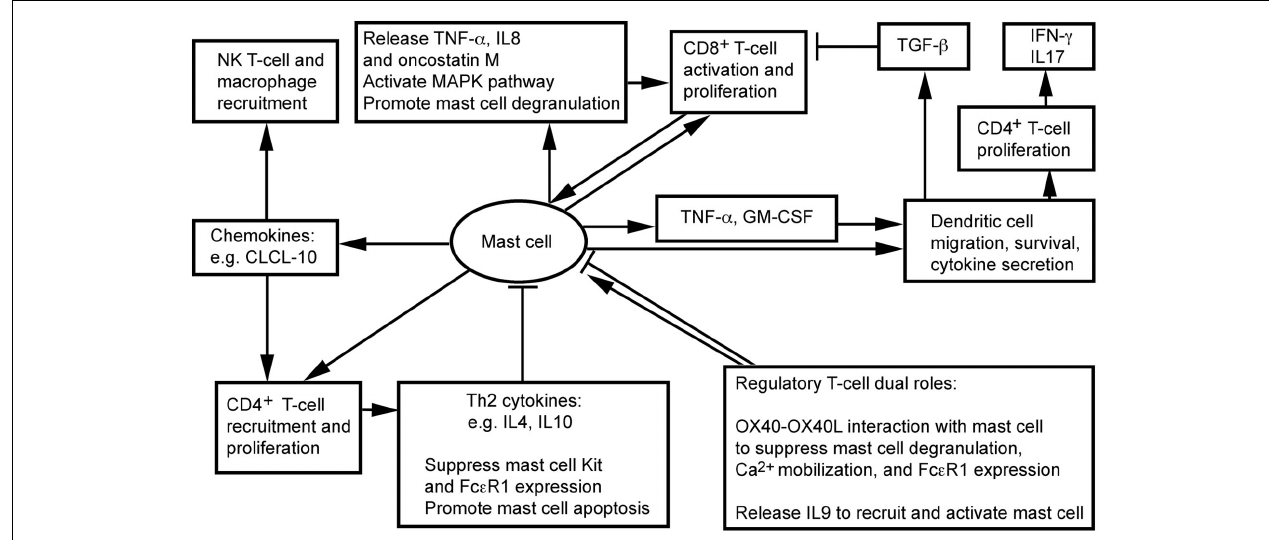
FIGURE 1 | Possible interactions between mast cells and inflammatory cells in adipose